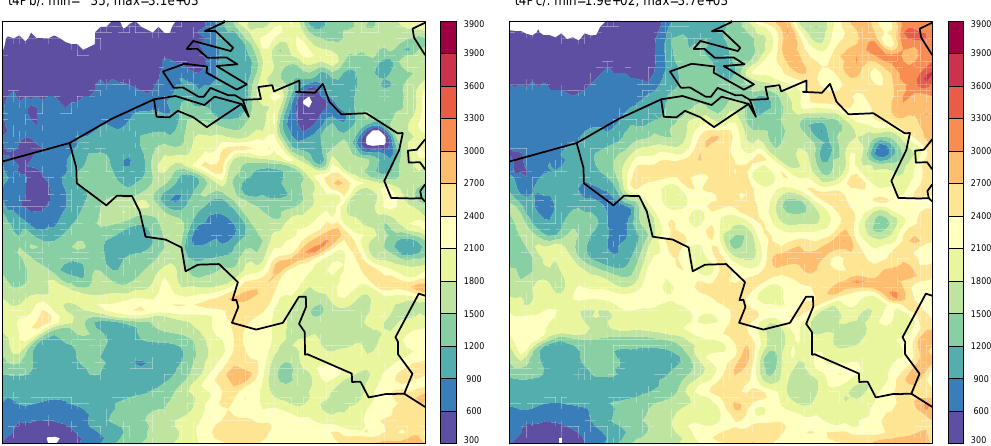
Fig. 2. Preliminary results of new prognostic convection scheme in Alaro model, 4 km resolution run on a limited area, with 41 vertical levels. Left: moisture convergence closure, right: CAPE closure. 1h accumulated precipitation (mm), precipitation scale is shown by a half scale of the radar image.